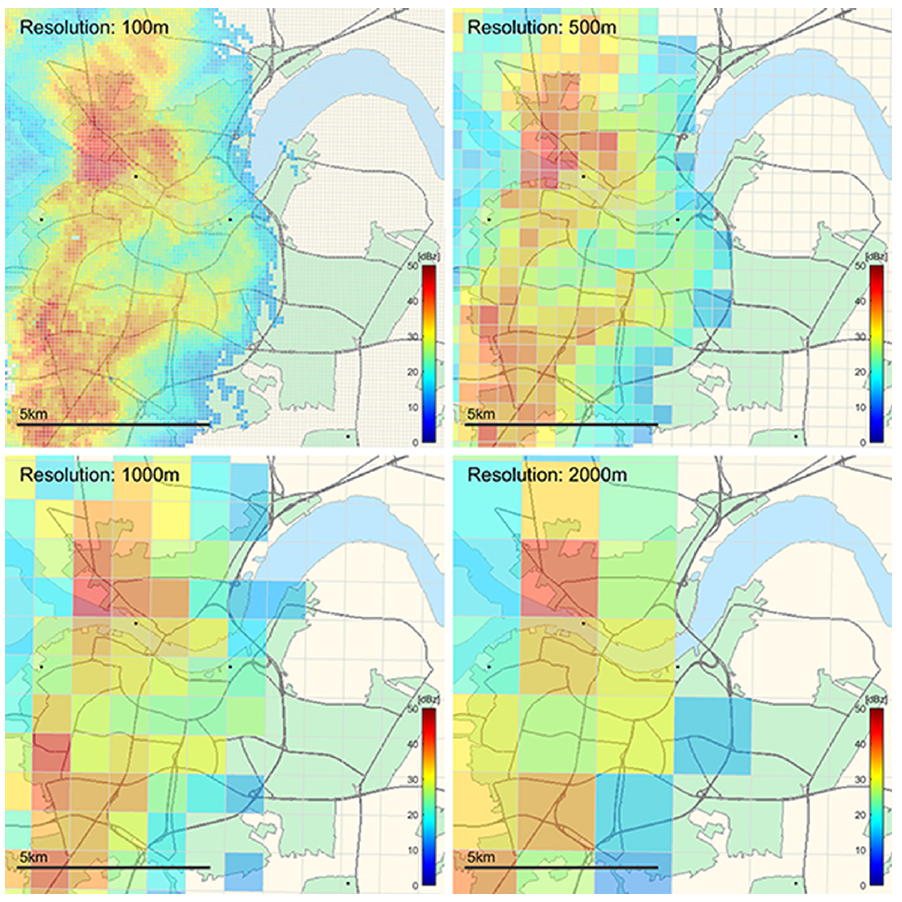
Figure 2. Example of radar reflectivity at four different Cartesian spatial resolutions over Aalborg, Denmark (lat: 57.05; lon: 9.92). The radar data are acquired with a Furuno WR-2100 dual-polarimetric X-band radar (Nielsen et al., 2015) at 1min temporal resolution at 16:20:00UTC on 25 July 2016. Black circles are rain gauges of the Danish Water Pollution Committee